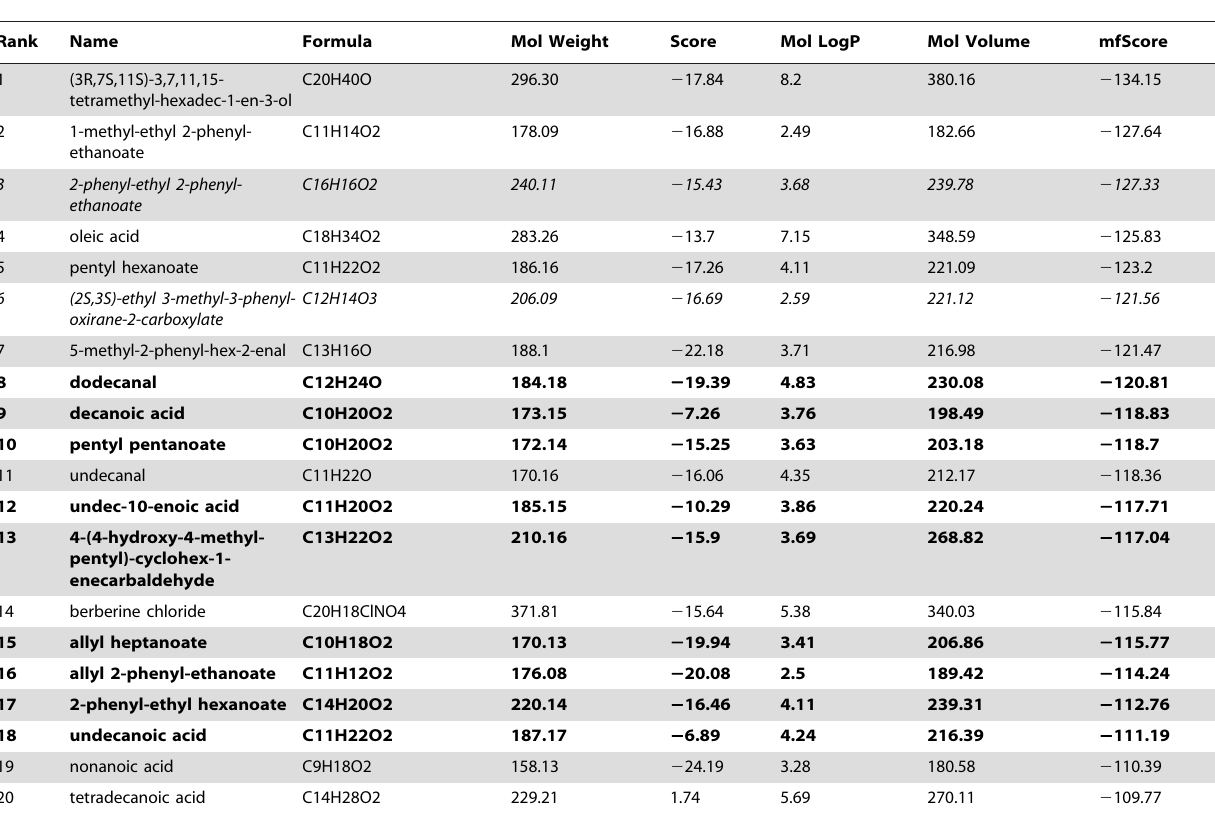
Table 2. Properties of the top 20 candidates as ranked by mfscore.